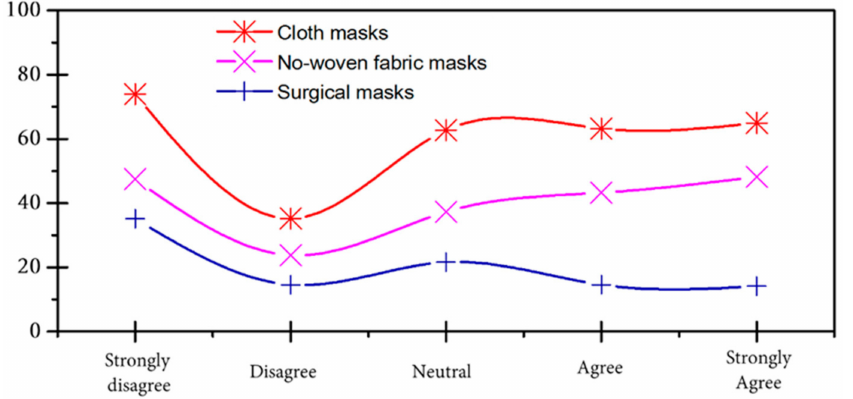
Figure 9. Comparison of the types of facemasks